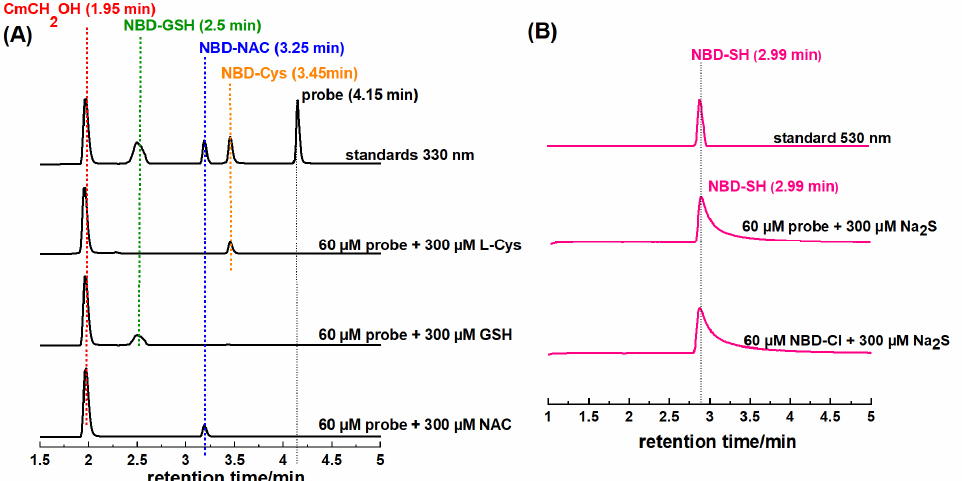
Figure 4. ( A ) HPLC chromatogram recorded at 330 nm of the standards and the reactions products of NBD-O-CmCH 2 OH (60 μ M) with various biothiols (each 300 μ M). ( B ) HPLC chromatogram recorded at 530 nm of the NBD-SH standard and the reaction mixtures of probe and NBC-Cl (60 μ M) with Na 2 S (300 μ M). The incubation time was 15 min.